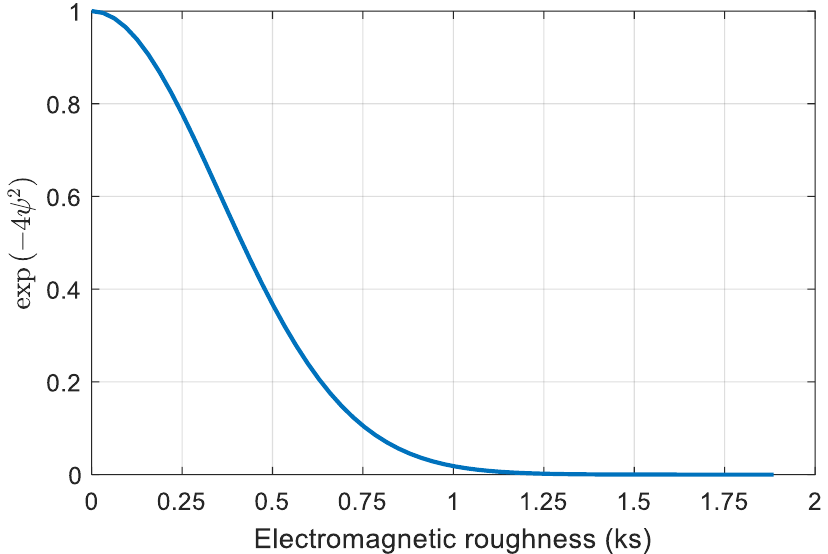
Figure 1. Effect of the electromagnetic roughness on the reflectivity